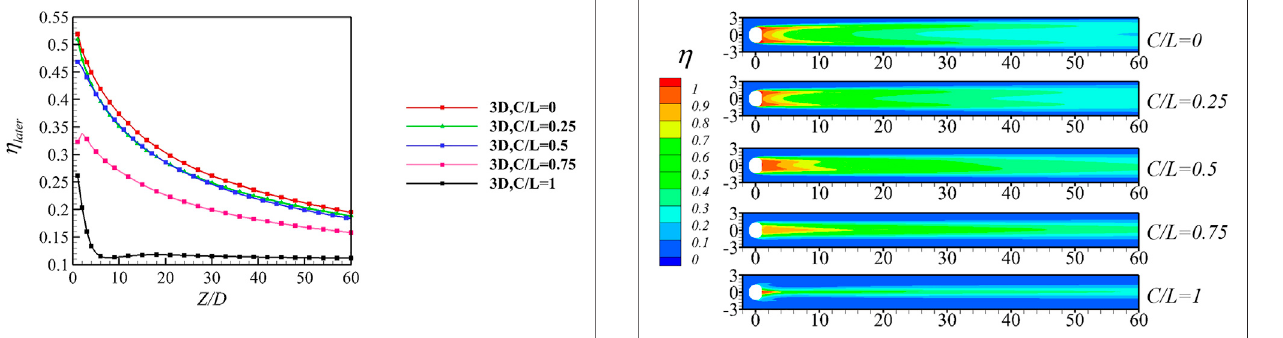
FIGURE 11 | Adiabatic cooling effectiveness contour in M (cid:2) 1.5